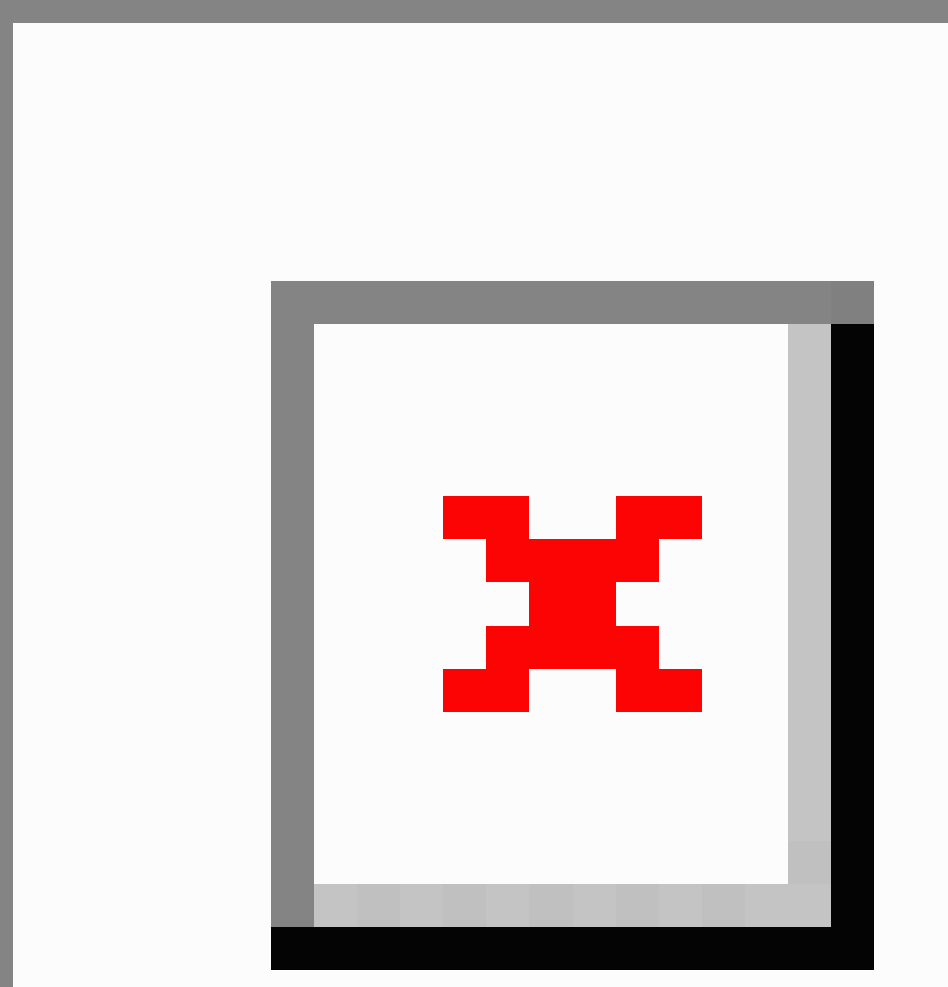
Figure 1. Top themes organized by group, using the top six phrases from the NGT